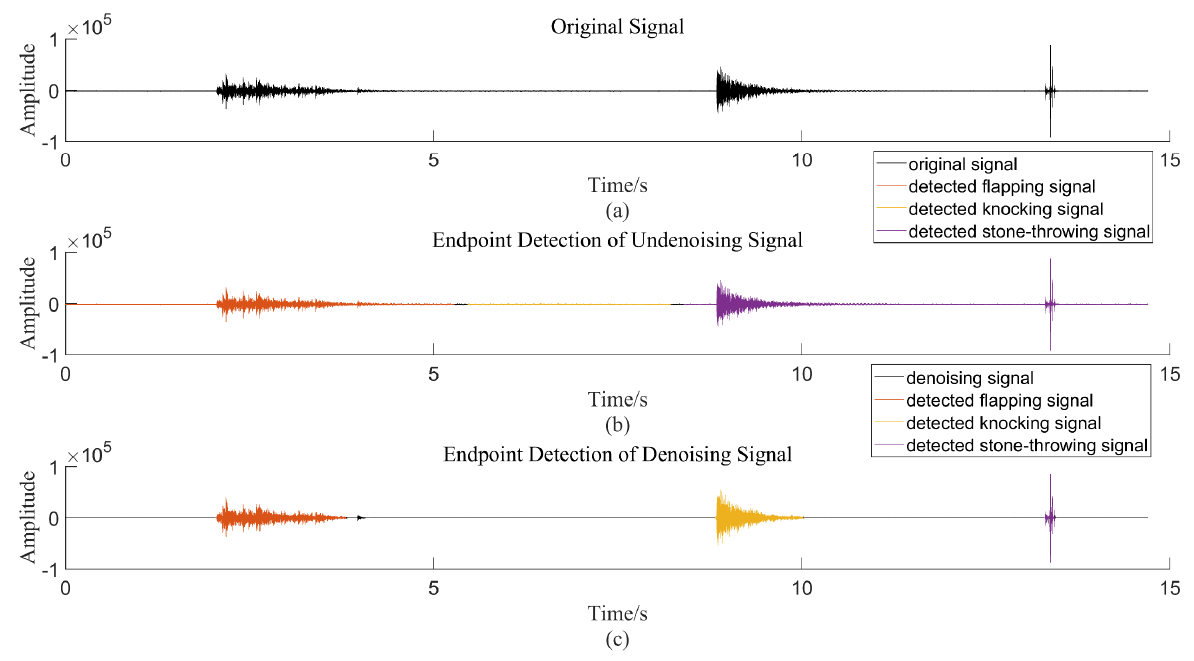
Figure 9. Endpoint detection method based on short-term energy combined with spectral spread. ( a ) Original Signal; ( b ) Endpoint Detection of Undenoising Signal; ( c ) Endpoint Detection of Denoising Signal.